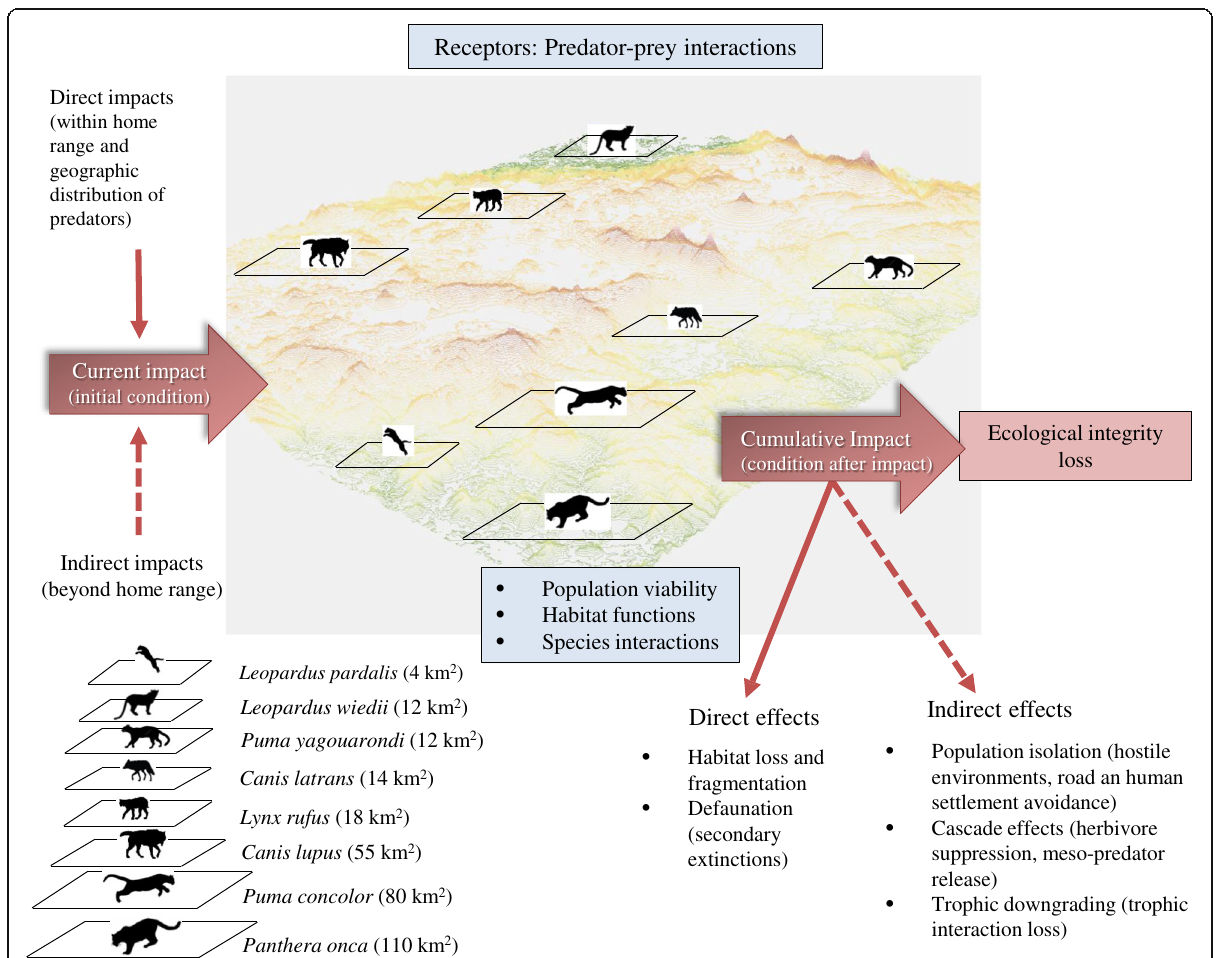
Fig. 1 A conceptual framework for evaluating anthropogenic impacts on ecological processes (predator-prey interactions) and (direct and indirect) effects associated (habitat loss and fragmentation, defaunation, and population isolation) with the ecological integrity loss. Impact levels are evaluated at different scales (home range) for all apex predators in